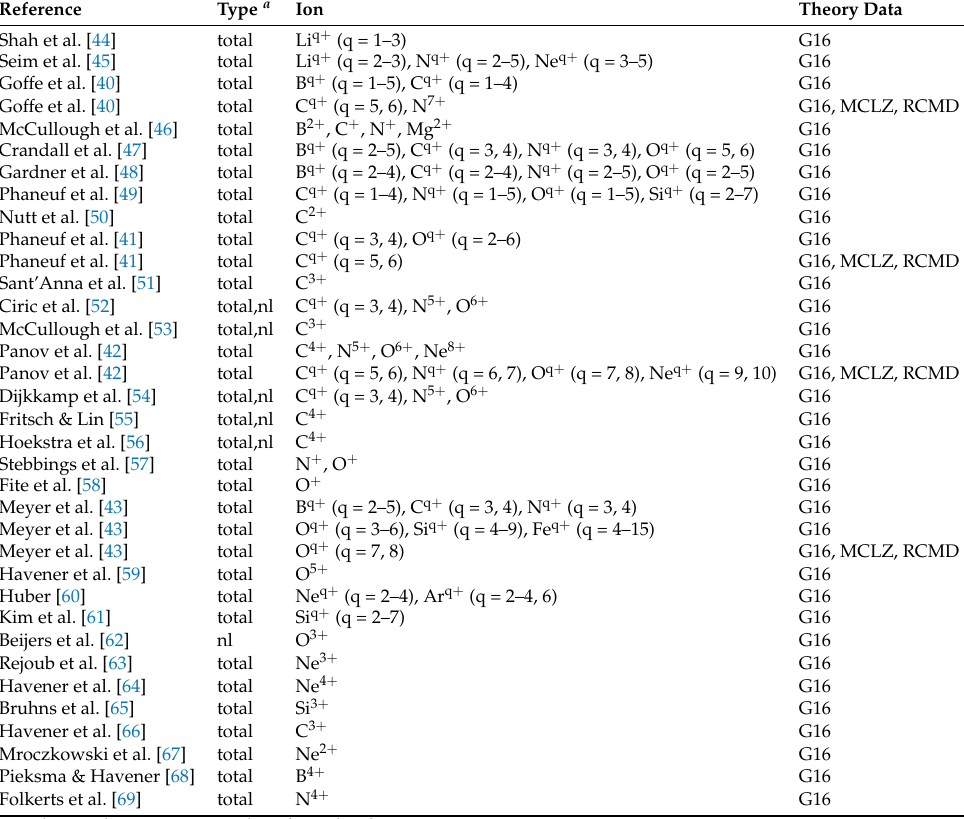
Table 1. Experimental cross section